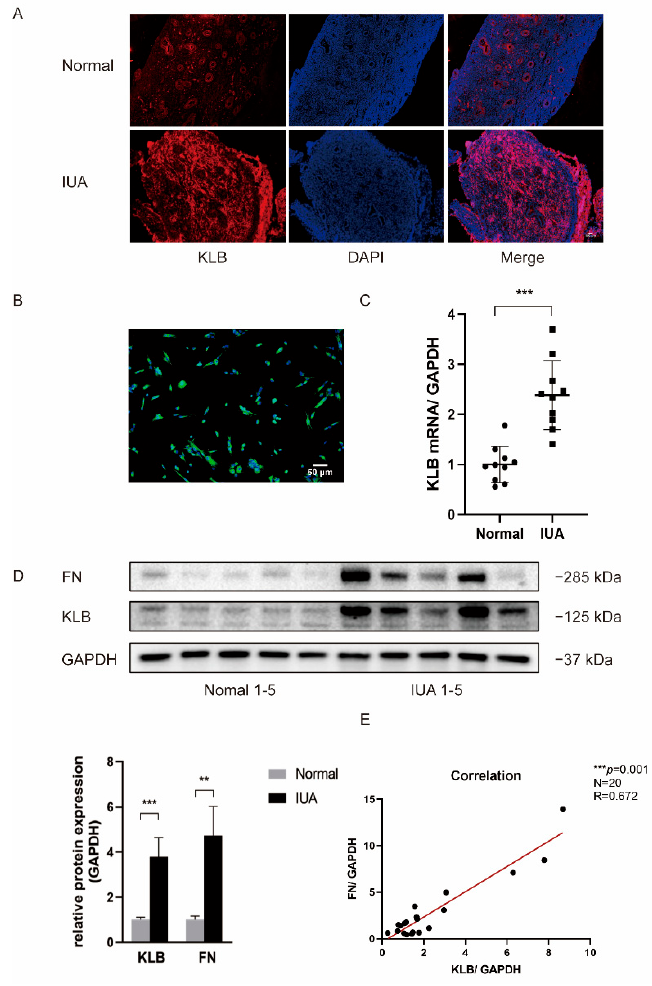
Figure 1. KLB expression was elevated in ESCs of patients with IUA. ( A ) KLB was expressed in both stromal and epithelial cells. Compared with the normal control group, the expression of KLB in ESCs of patients with IUA was increased. Scale bar = 100 μ m. ( B ) The primary ESCs were extracted and identified with Vimentin. Immunofluorescence showed that the positive rate of Vimentin was more than 96%. Scale bar = 50 μ m. ( C ) Through RT-qPCR analysis, it was found that the expression of KLB mRNA in the primary ESCs of the IUA group was higher than in those of the normal control group. ( D ) The expression of KLB and the fibrosis marker Fibronectin (FN) in primary ESCs of the IUA group and normal control group was detected and analyzed using Western blotting. It was found that the expression of KLB and FN increased in the primary ESCs of IUA patients. ( E ) Spearman rank correlation analysis showed that the expressions of KLB and FN proteins in ESCs were positively correlated. ** p < 0.01; *** p ≤ 0.001.